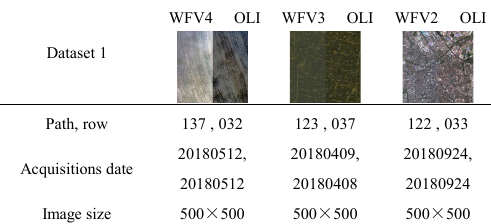
Table 2. GF-1 WFV and Landsat-8 OLI study areas